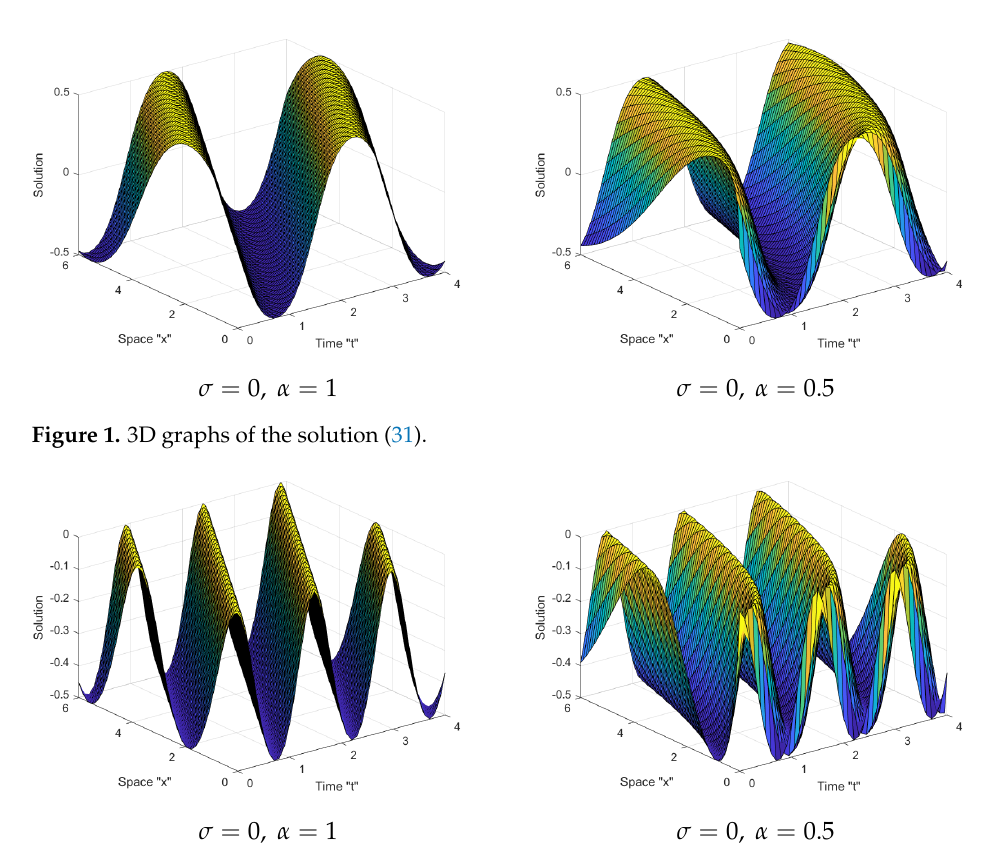
Figure 2. 3D graphs of the solution (32).